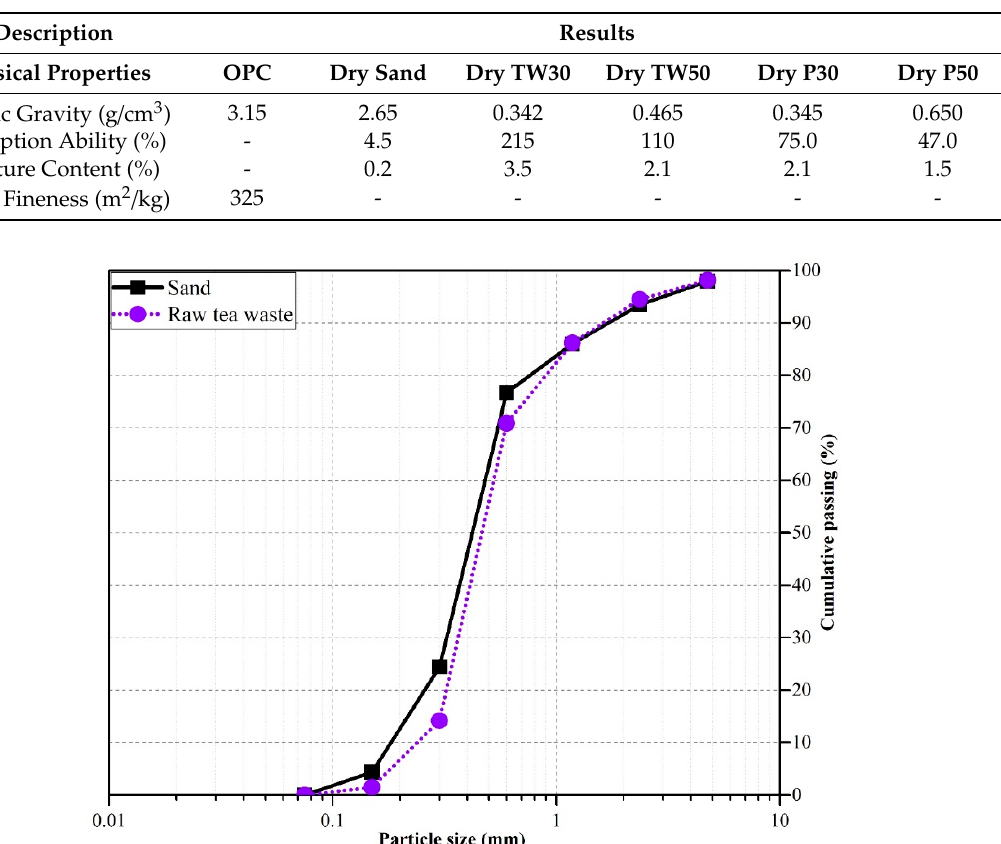
Figure 1. Gradation curves of sand and raw tea waste.